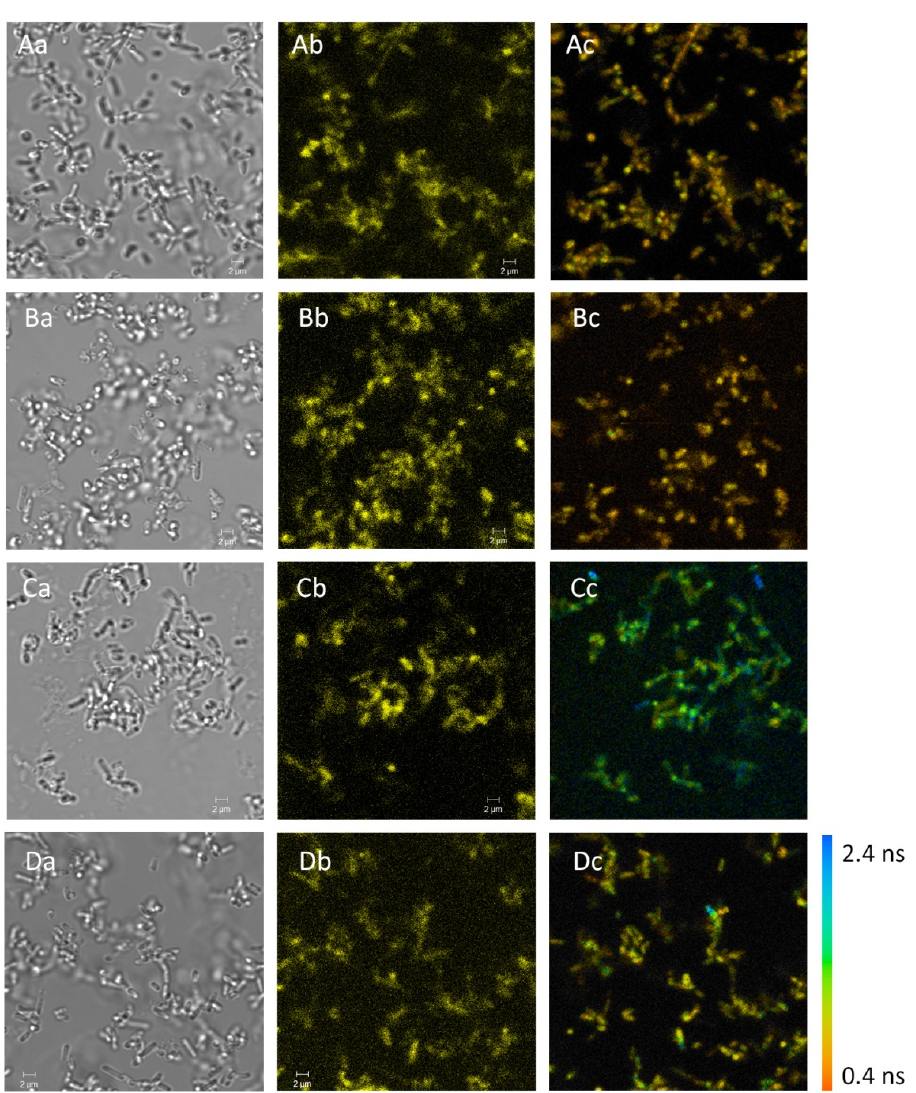
Figure 3. E. coli cells imaged by optical microscopy in control conditions ( A ), after 5 cycles of cascade reaction in free cells ( B ), after 5 cycles of cascade reaction in entrapped cells ( C ), and in control cells with addition of 10 mM glucose ( D ). Optical contrast: transmission ( a ), fluorescence intensity ( b ), and mean fluorescence lifetime ( c ) color-coded according to the given scale.